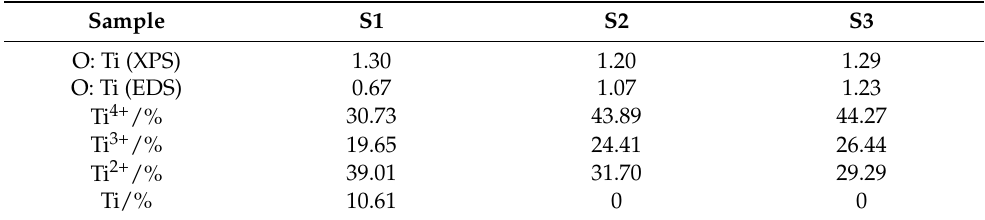
Figure 2. The binding energy of Ti 2p on the surface of the films before etching: ( a ) S1, ( b ) S2, and ( c ) S3; the binding energy of Ti 2p on the surface of the films after etching: ( d ) S1, ( e ) S2, and ( f ) S3. Table 2. O: Ti atomic ratio of the three samples and valence distribution of Ti